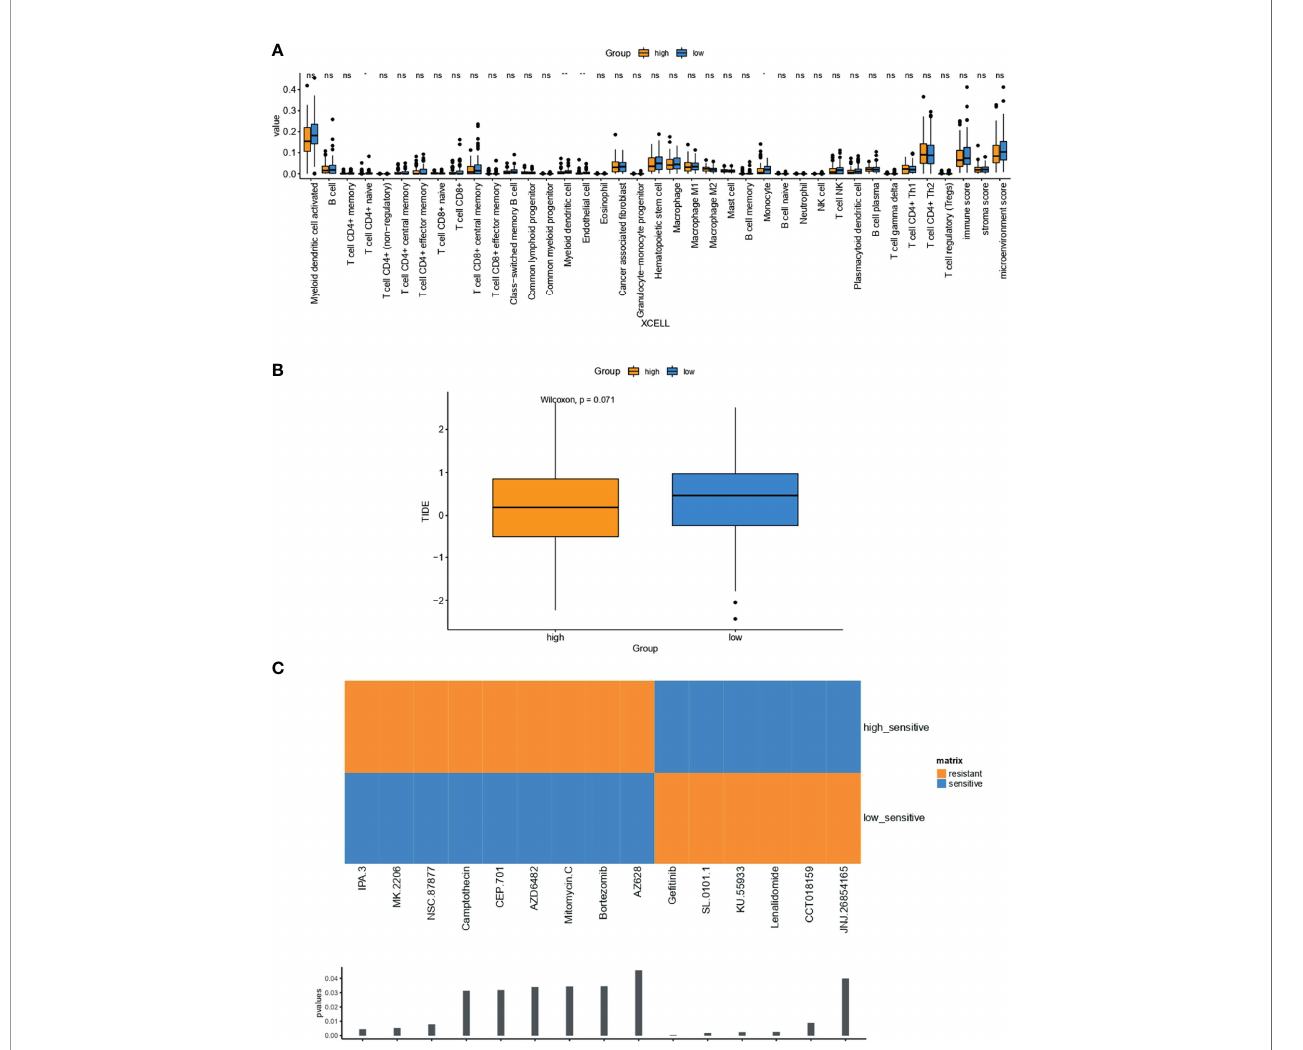
FIGURE 9 | Estimation of the associations between immune characteristics, potential therapy, and the IPR signature. The difference in the abundance of tumor- in fi ltrating immune cells were analyzed by XCELL (A) in the training cohort, independently. (B) The difference in TIDE value between high- and low-IRP signature group. (C) Drugs with signi fi cantly different sensitivity were analyzed by utilizing the GDSC dataset. TIDE, tumor immune dysfunction and exclusion. *p < 0.05; **p < 0.01; ns, not signi